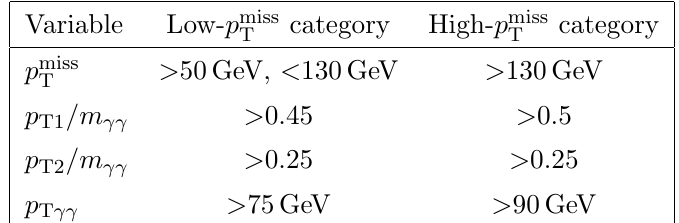
Table 1 . Optimized kinematic requirements for the low- and high- p miss